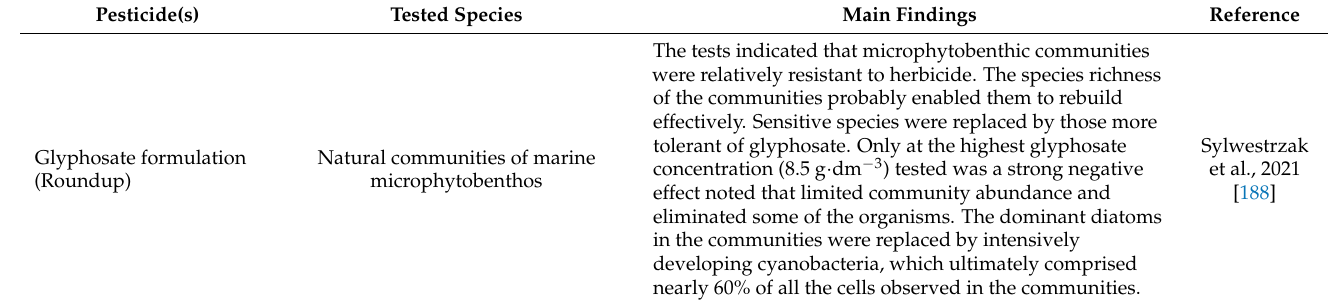
Table 4. Selected studies evaluating the toxicity of pesticides on marine plant and animal species.